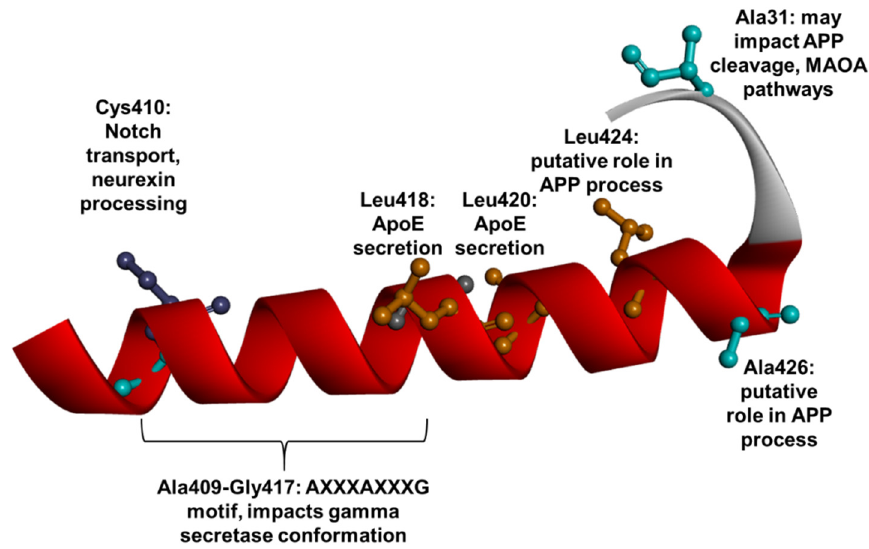
Figure 12. Significant residues located in TM8 and HL8